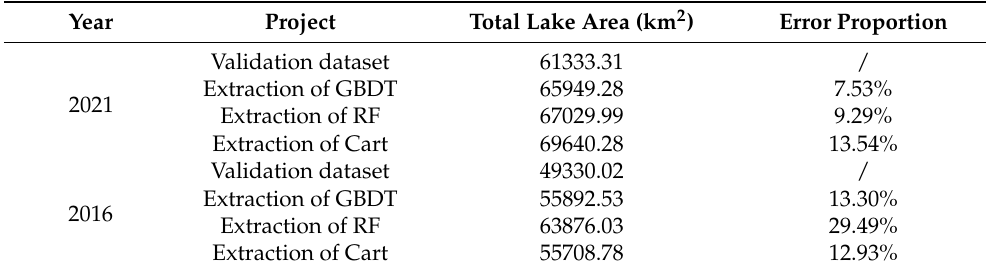
Table 6. Comparison of extracted area and validation datasets of lakes on the Tibetan